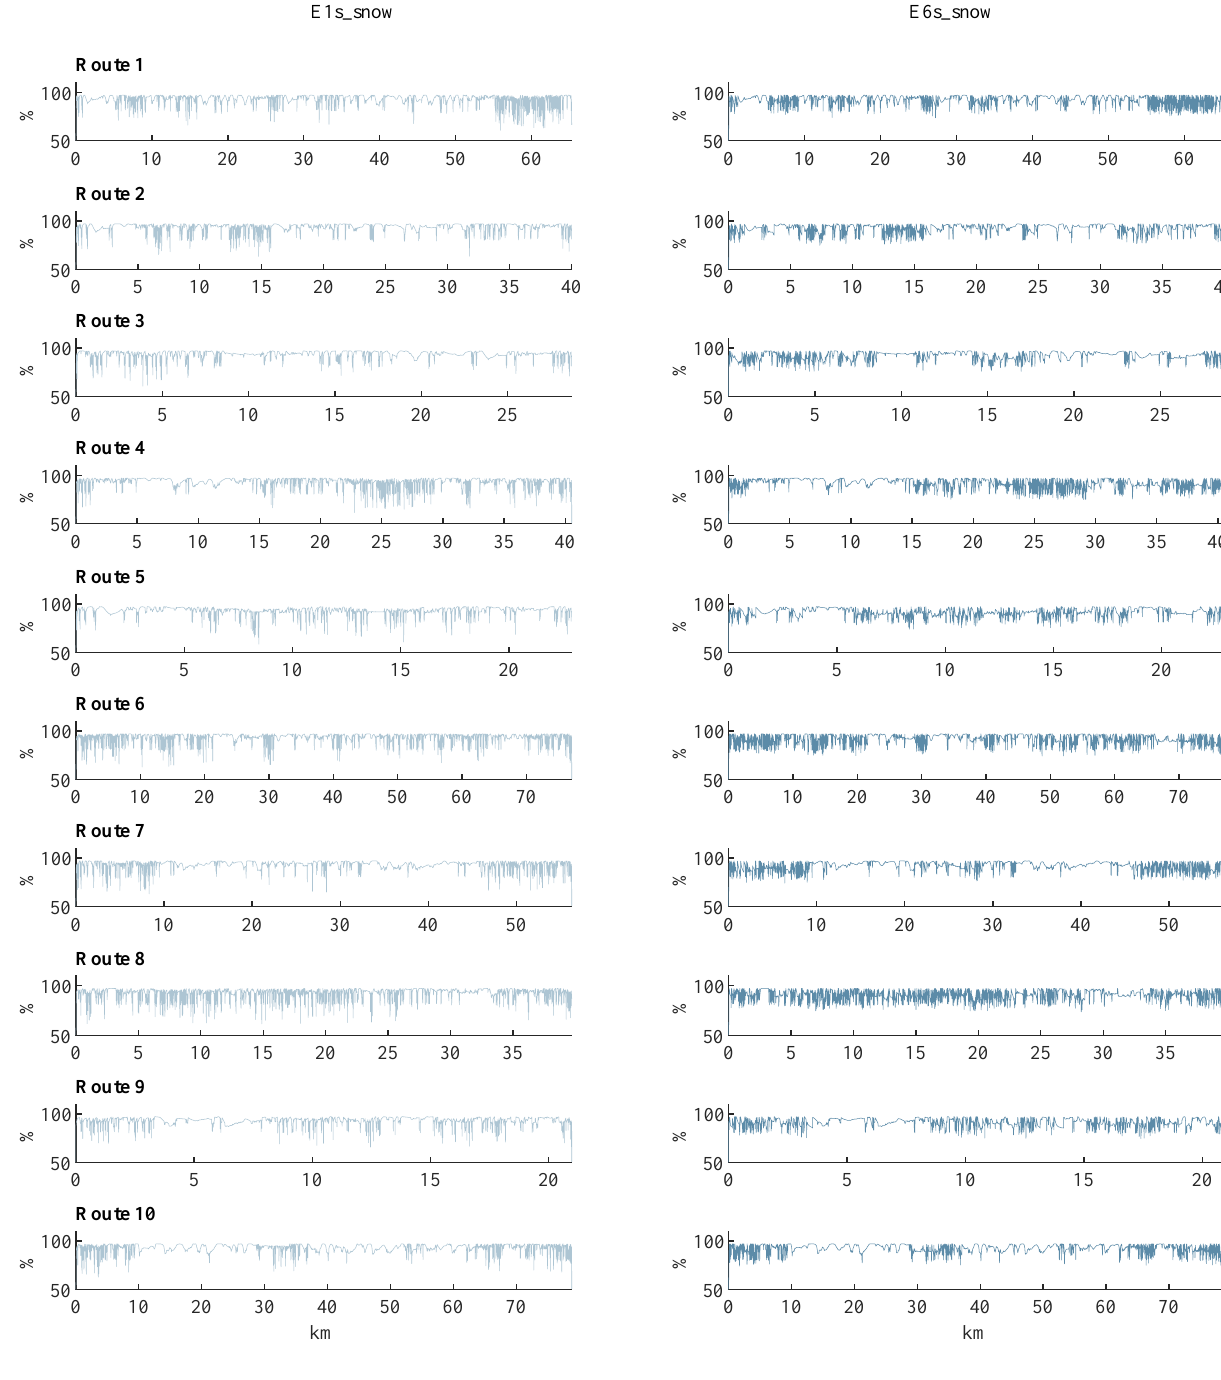
Figure A6. Electric powertrain efficiency with the snow load on routes